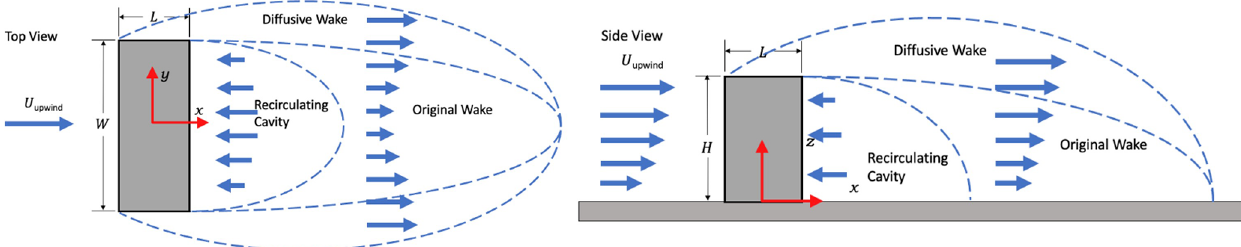
Figure 6. The regions where the two wake algorithms, diffusive wake and recirculating cavity, are applied downwind of the building in the QUIC